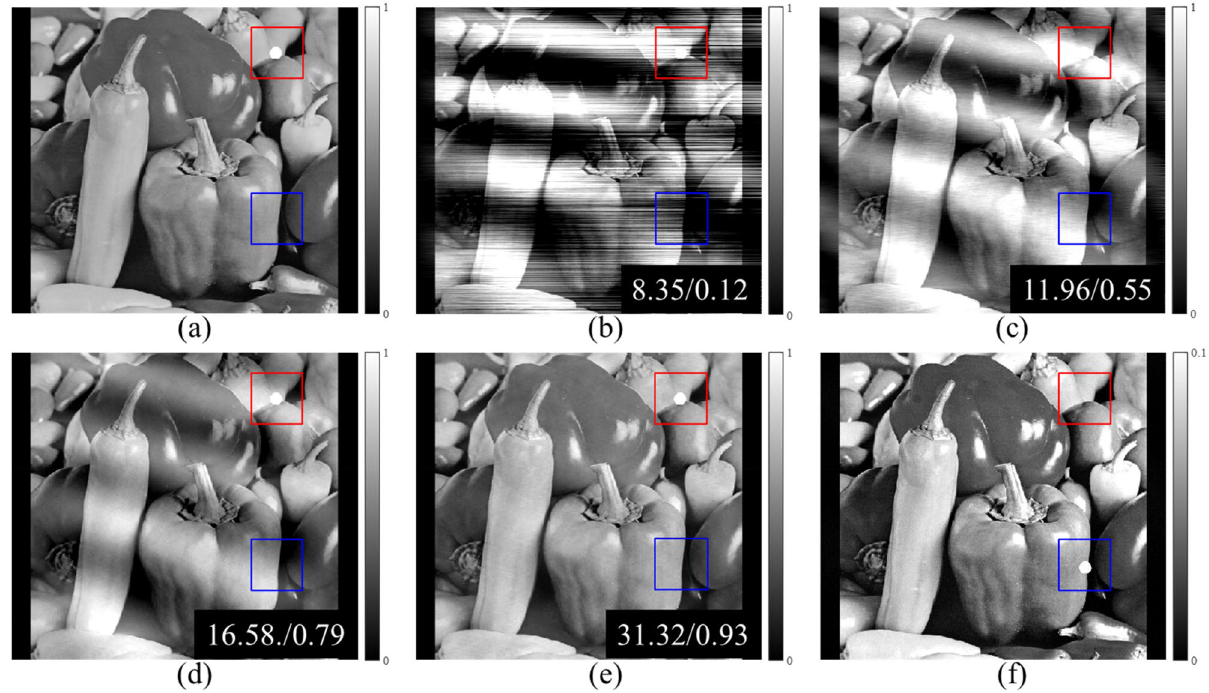
Figure 4. Comparison results for peppers image from USC-SIPI image database. ( a ) Reference, ( b ) direct integration, ( c ) Wavelet-Fourier filtering, ( d ) iterative method, ( e ) The proposed method, ( f ) transmission. The display window for ( f ) is [0, 0.1], the others is [0, 1], respectively. The PSNR and SSIM values are displayed in the images. The blue and red area show the points in the transmission image and the phase contrast image, respectively.